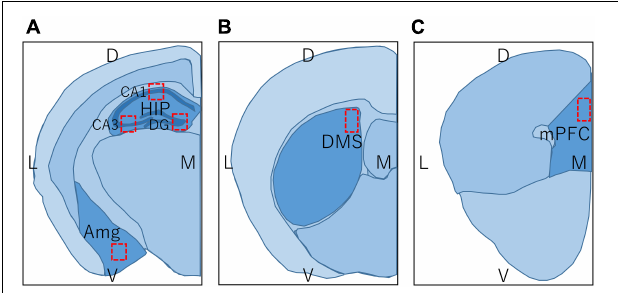
FIGURE 3 | Regions in the brain of mice used in immunohistochemistry and immunoblot. L, lateral; M, medial; D, dorsal; V, ventral; HIP, hippocampus; CA1, hippocampal CA1 region; CA3, hippocampal CA3 region; DG, dentate gyrus; Amg, amygdala; DMS, dorsomedial striatum; mPFC, medial prefrontal cortex. Brain section map of the hippocampus and amygdala ( A ; bregma –1.34 to –2.06 mm), DMS ( B ; bregma –0.10 to 0.98 mm), and prelimbic region of mPFC ( C ; bregma 1.70 to 1.98 mm). Rectangles in (A–C) represent the areas in which the number of c-Fos positive cells was